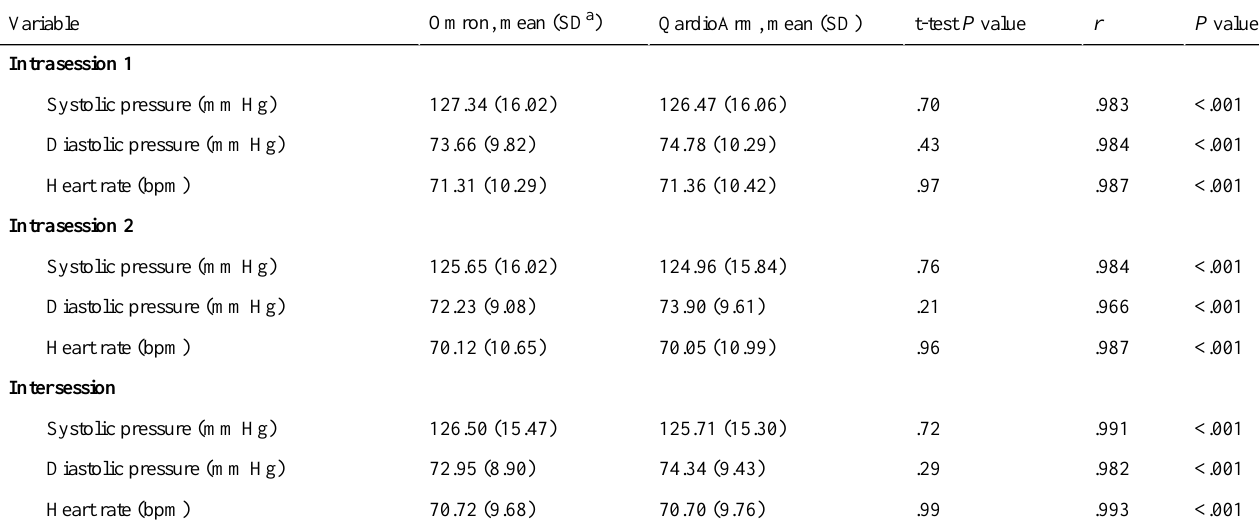
Table 4. Comparison of Qardioarm and Omron devices in mean estimates and correlations of individual means between devices.